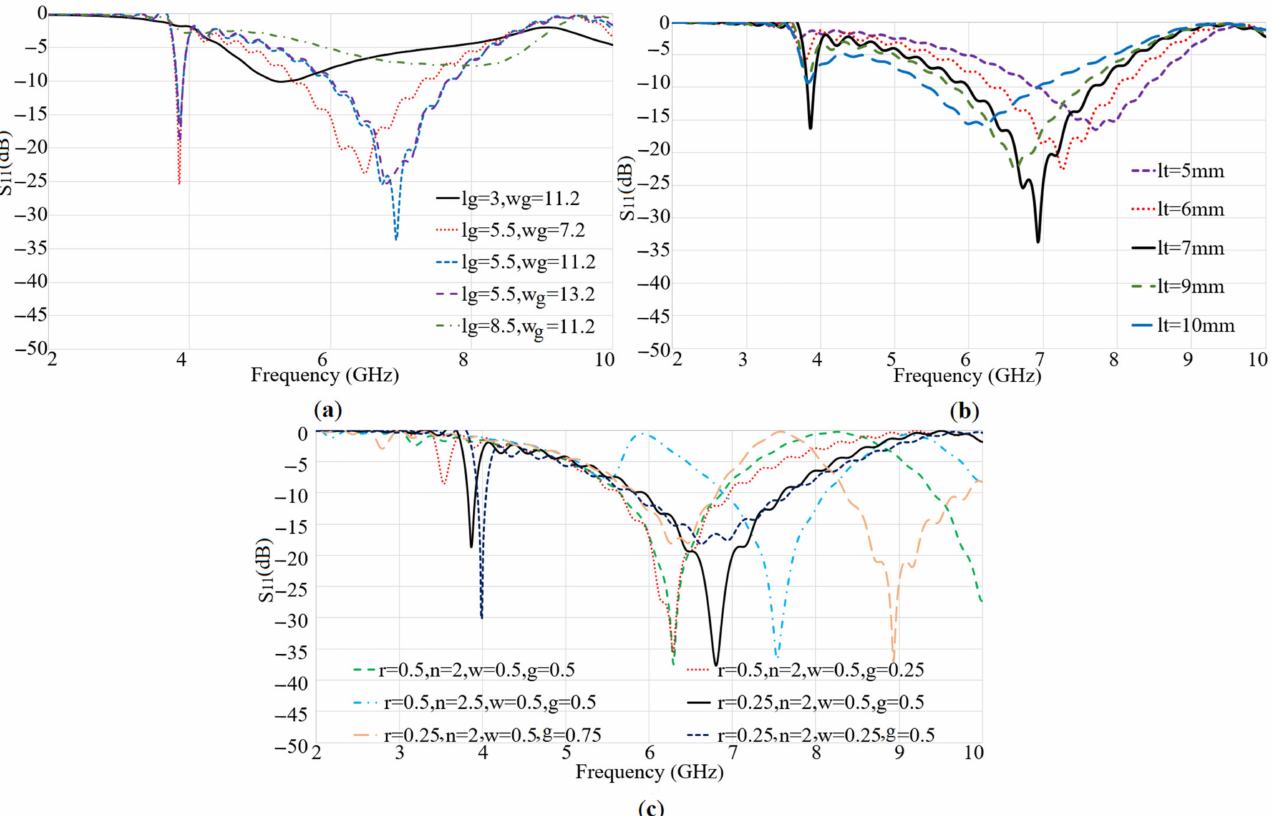
Figure 4. Parametric study of the spiral patch antenna dimensions: ( a ) lg: ground length (L g ) and wg: width (W g ), ( b ) lt: feed line length (L t , ( c ) spiral dimensions: internal radius (r), number of turns (n), line width (w), and the gap between lines